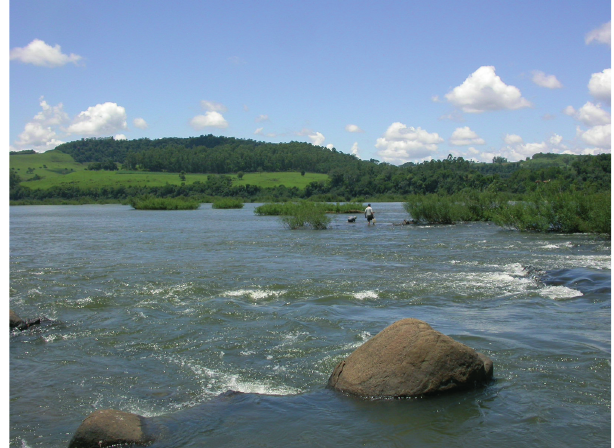
Fig. 4 . Rio Uruguay, on the road Barra do Guarita-Palmitinho, Barra do Guarita, Rio Grande do Sul. General view of the ex- plored riffle stretch where were captured specimens of C.